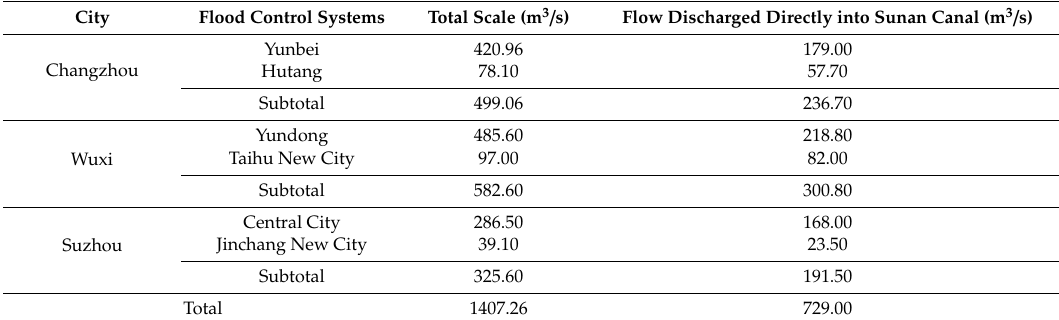
Table 1. Urban flood control systems of Sunan Canal.